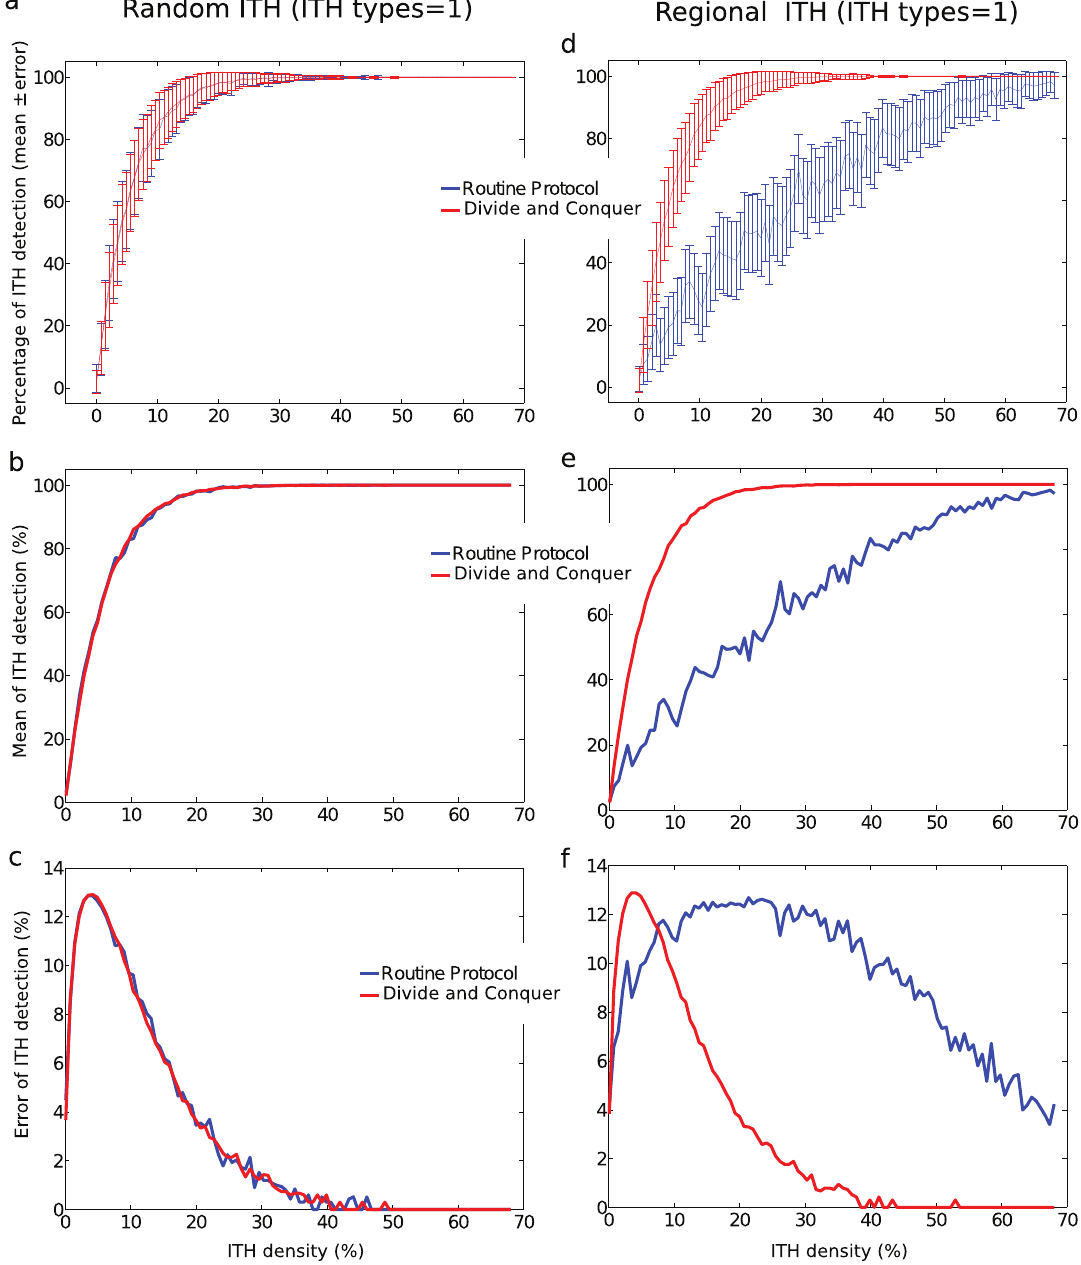
Figure 2. Results from the computational modeling approach show that, for tumors with ITH types=1, DAC (red) performs similar to RP (blue) for random ITH ( a – c ) but the former outperforms the latter for regional ITH ( d – f ). a , c : Percentage of ITH detection (mean ± SD) as a function of the percentage of ITH density defining for each tumor. SD was calculated across N different repetitions of the same strategy and across M different tumors. b , e : similar to a , c but we only represented the mean. c , f : similar to a , c , but we only represented SD. Notice that, not only the mean of ITH detection was drastically enhanced by DAC, but SD was substantially smaller, meaning that DAC in comparison to RP is more efficient and more reliable (less variable). Exact values for all simulated parameters are given in the